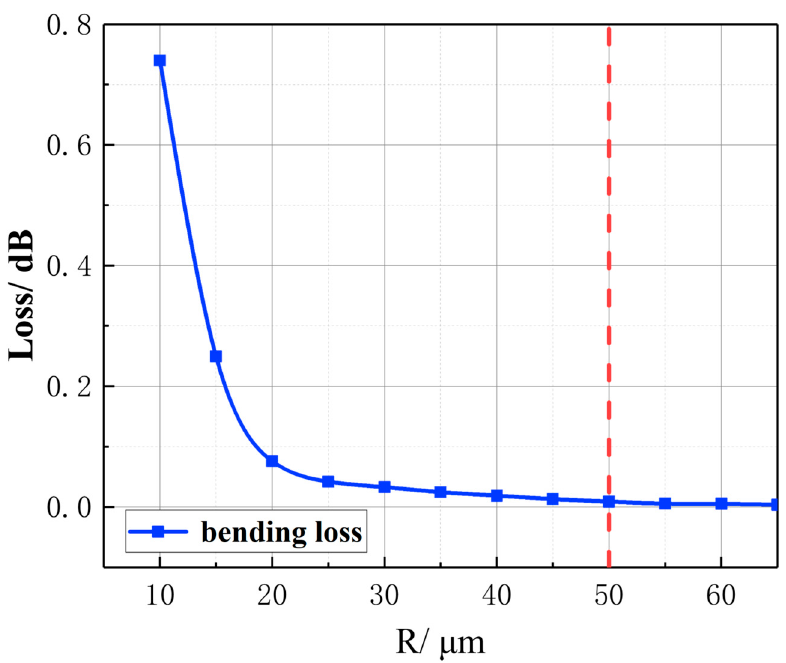
Figure 3. The simulation curve of the waveguide bending loss per 90° under di ff erent bending radii.